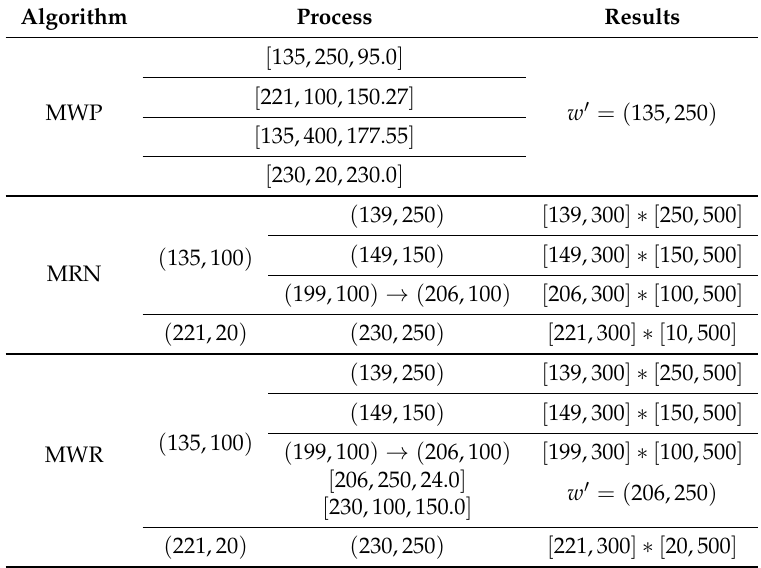
Table 1. Results of MWP, MRN and MWR algorithms, where w = h 2 and w ∈ R ( h 2 = ( 230,250 ) ).